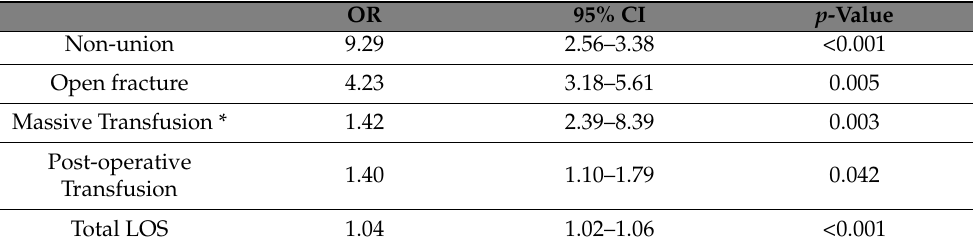
Table 5. Multivariate models demonstrating associations of development of a deep infection follow- ing a subtrochanteric